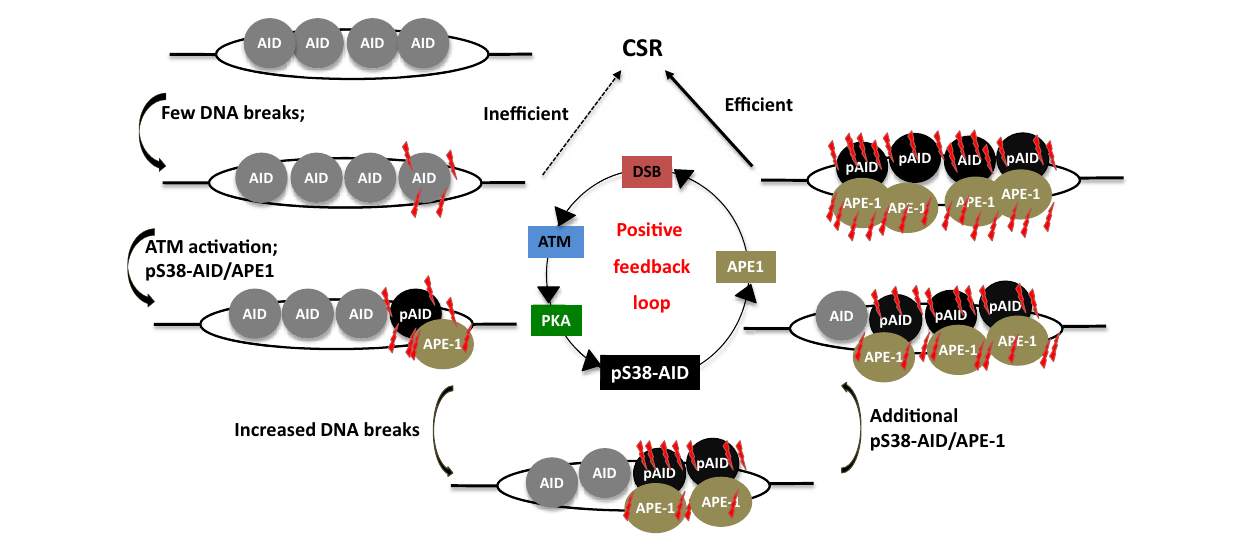
Active recruitment of APE1 to DNA accentuates DSB formation, which in turn induces phosphorylation of additional molecules of AID, thereby perpetuating the DSB amplification loop.This promotes the generation of high density of DSBs at S regions that is required for